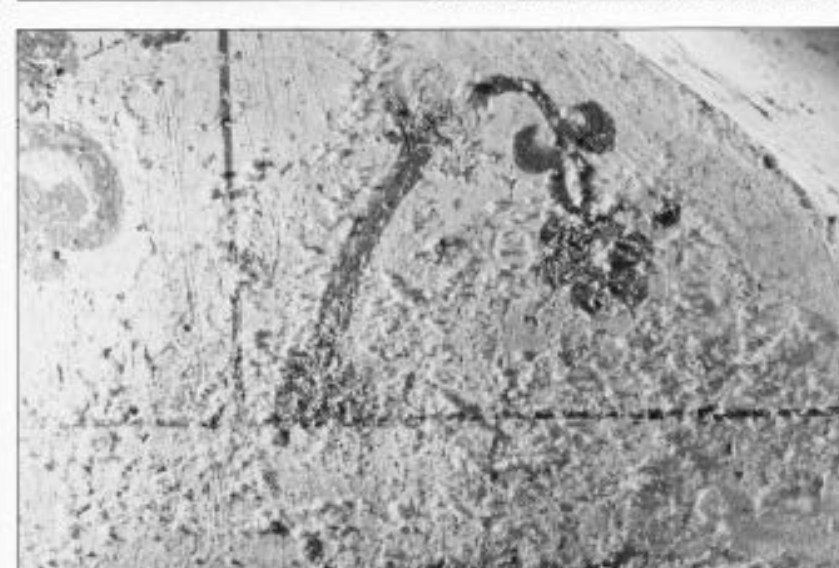
Figure 3 Detail of one of the wall-painting scenes in the nave ofHardham Church, 1997, showing severe disruption of the painted surface caused by salt crystallization. amelioration is difficult to get right,